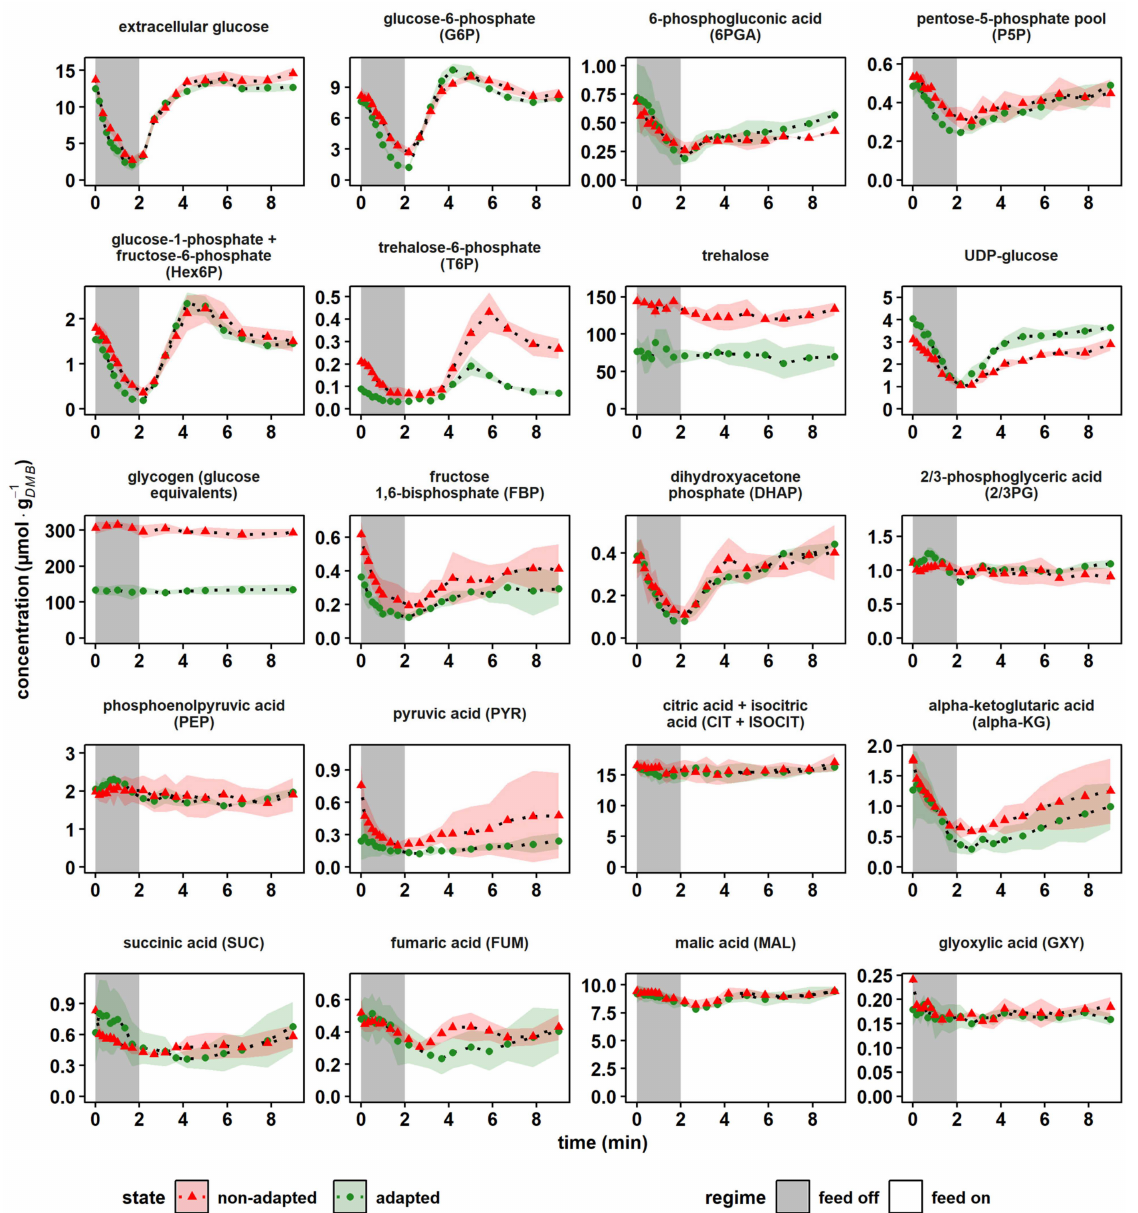
Figure 4. Dynamics of central catabolic metabolites after a 2 min glucose depletion phase. The nonadapted response (red) indicates dynamics following a single transition into a starvation scenario (“feed off” phase) and the adapted response (green) was sampled from representative 9 min cycles during steady-state DS. Time point 0 min of the non-adapted response was equal to steady-state RS. All values indicate means ± standard deviation of three biological